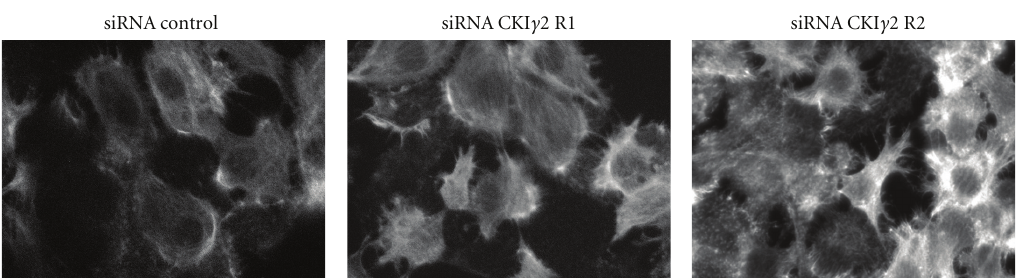
Figure 4: Increased actin stress fibers in HaCaT cells transiently transfected with hCKI γ 2 siRNAs. HaCaT cells transiently transfected with siRNA control or siRNAs targeting two independent coding regions of hCKI γ 2 (R1, R2) were subjected to actin staining using phalloidin- coupled to AlexaFluor 488. Pictures were taken at